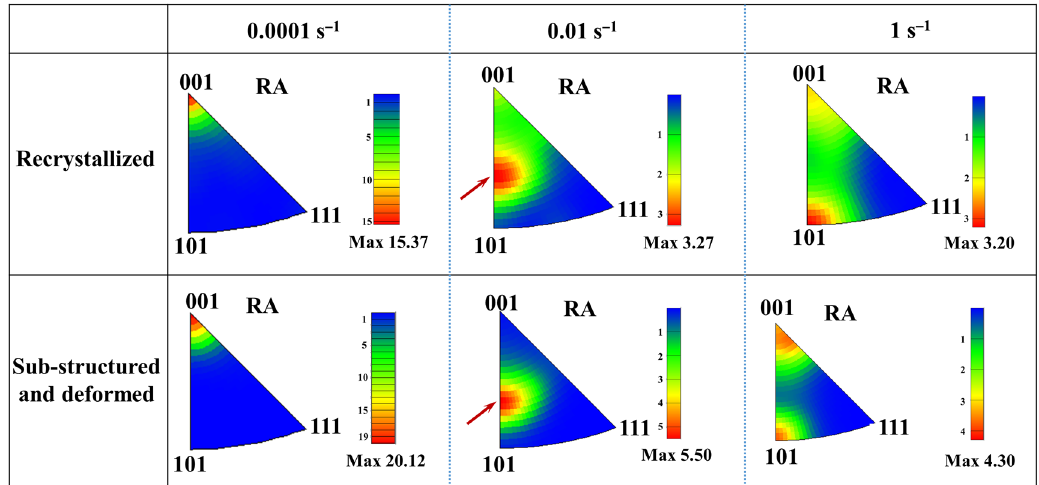
Figure 11. The IPFs of the recrystallized β phase and the sub-structured and deformed β phase at various strain rates.